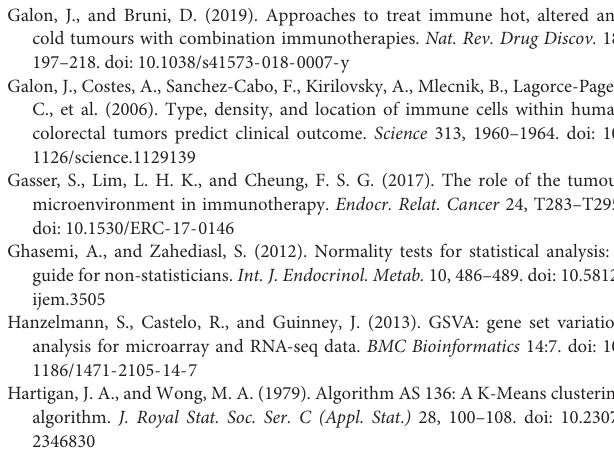
Supplementary Figure 2 | GSVA analysis and immune landscape based on TME clusters. (A) GSVA of TME clusters in TCGA-GO (B) . The expression pattern of seven types of immune checkpoints in TME clusters for TCGA. Supplementary Figure 3 | Genomic profiles associated with TME score. (A) GISTIC 2.0 amplifications and deletions in CESC with high TME score. Chromosomal locations of peaks of significantly recurring focal amplification (red) and deletions (blue). (B) Differential somatic mutations in CESC with high TME score. Supplementary Table 1 | GO pathways for TME clusters based on GSVA in TCGA. Supplementary Table 2 | 383 differentially expressed genes in TCGA. Supplementary Table 3 | 98 representative TME signature genes. Supplementary Table 4 | GO enrichment analysis for TME gene clusters based on 98 genes. Supplementary Table 5 | KEGG enrichment analysis for TME gene clusters based on 98 genes. Supplementary Table 6 | TME score for CESC patients in TCGA. Supplementary Table 7 | GSVA of TME score. Supplementary Table 8 | TME score for BRCA patients. Supplementary Table 9 | TME score for OV patients. Supplementary Table 10 | Characteristics of all the included patient